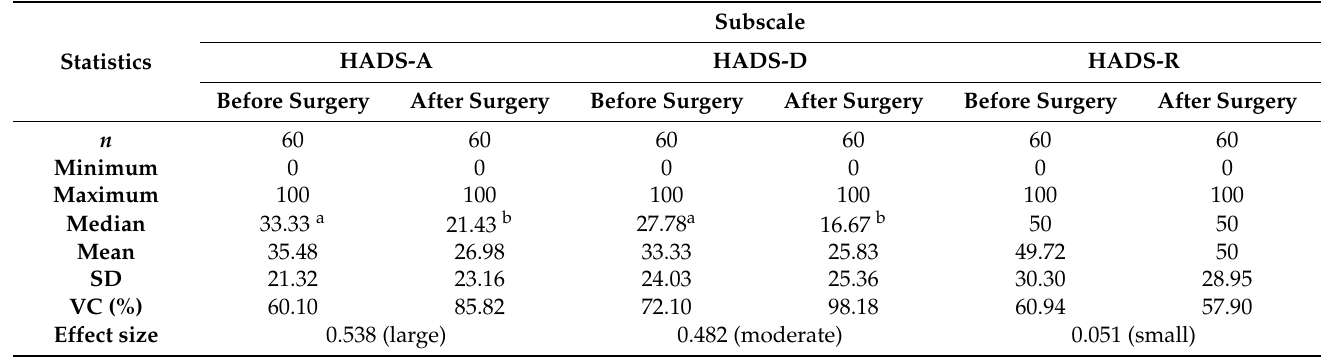
Table 2. HADS subscales for women before and 12 months after surgery.